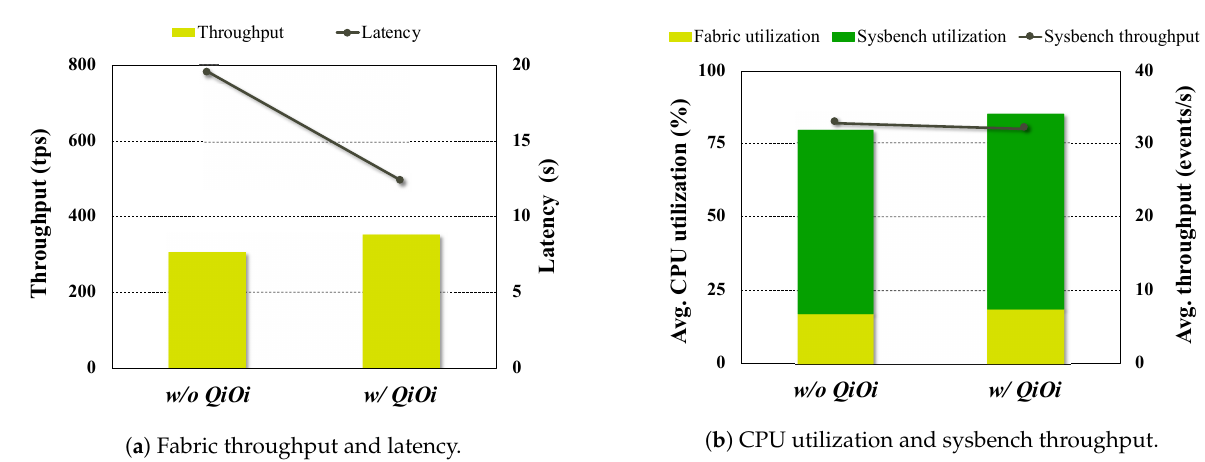
Figure 9. Impact of QiOi on Kafka ordering service-based Fabric network.